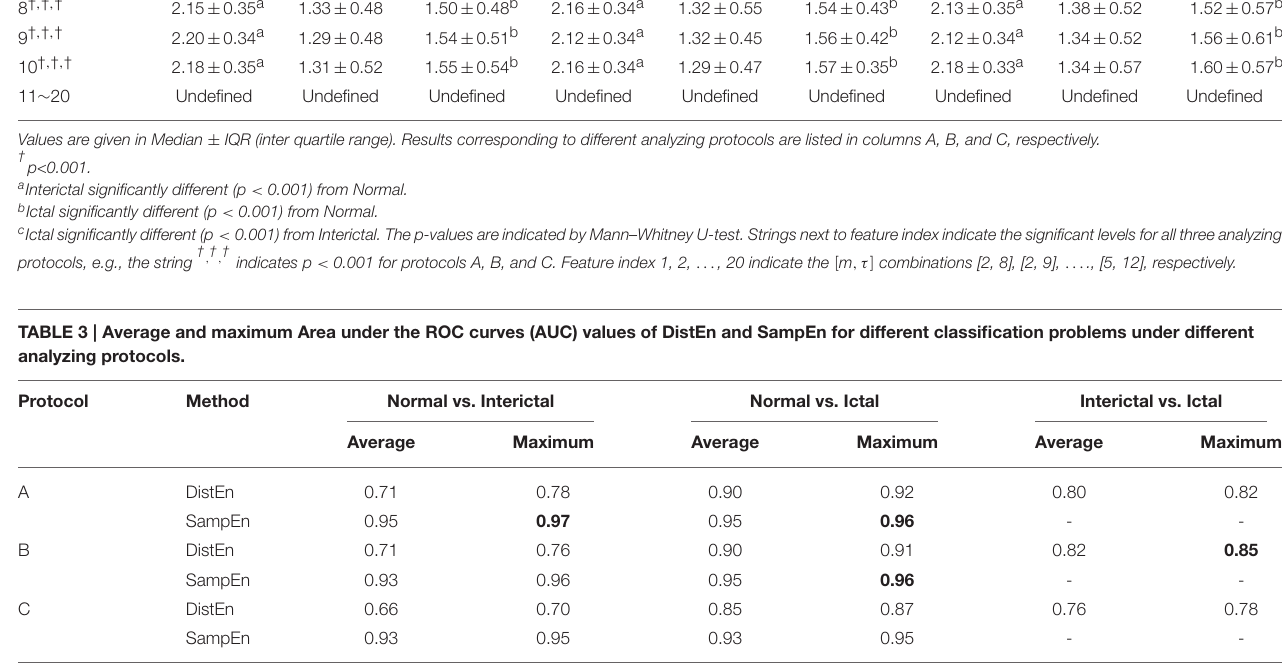
Bold indicates the maximum AUC for each of the three classification